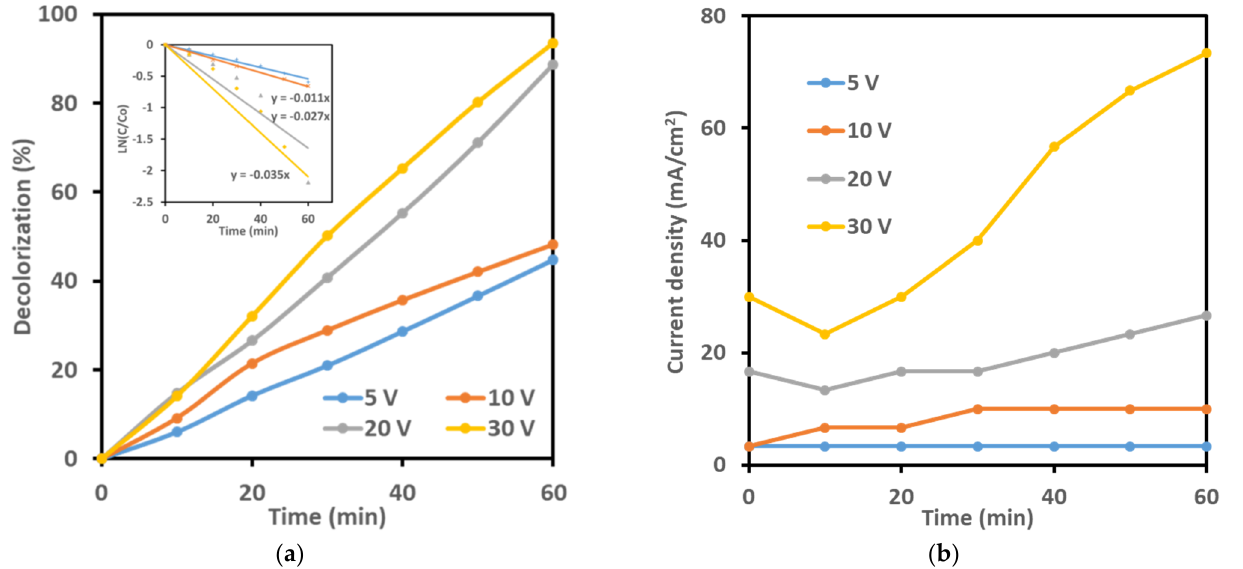
Figure 7. ( a ) Effects of cell voltage on decolorization efficiency. Na 2 SO 4 electrolyte: 0.05 g L −1 ; reaction time: 1 h; electrode distance: 3 cm; initial pH: 6.0; reaction temperature: 25 °C; MB: 9 mg L −1 ; cell voltage: 5~30 V. ( b ) Current density change vs. treatment times.